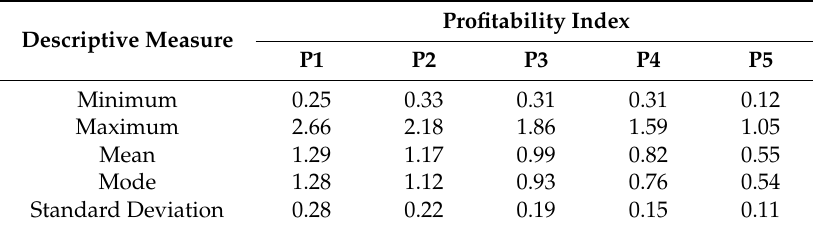
Table 4. Descriptive measures of the profitability index (PI) of investment projects in forest stands used for the biomass production of the main bole of eucalyptus.